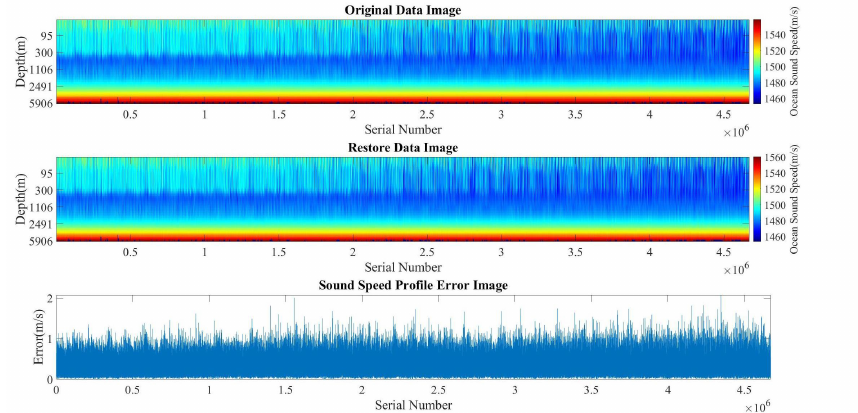
Figure 7. Performance of dictionary learning compression under spatial discrete structure ( k = 100, T =